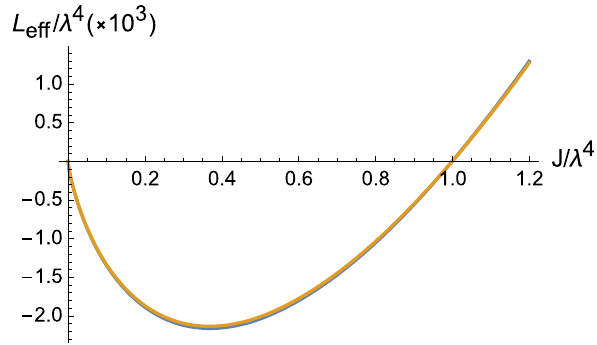
Fig. 1 The effective SU(2) YM theory Lagrangian dependence on J /λ 4 corresponding to one particular (chromoelectric) branch of the RG Eq. (4) with J > 0. The curves corresponding to the one-loop and all-loop effective Lagrangians are practically